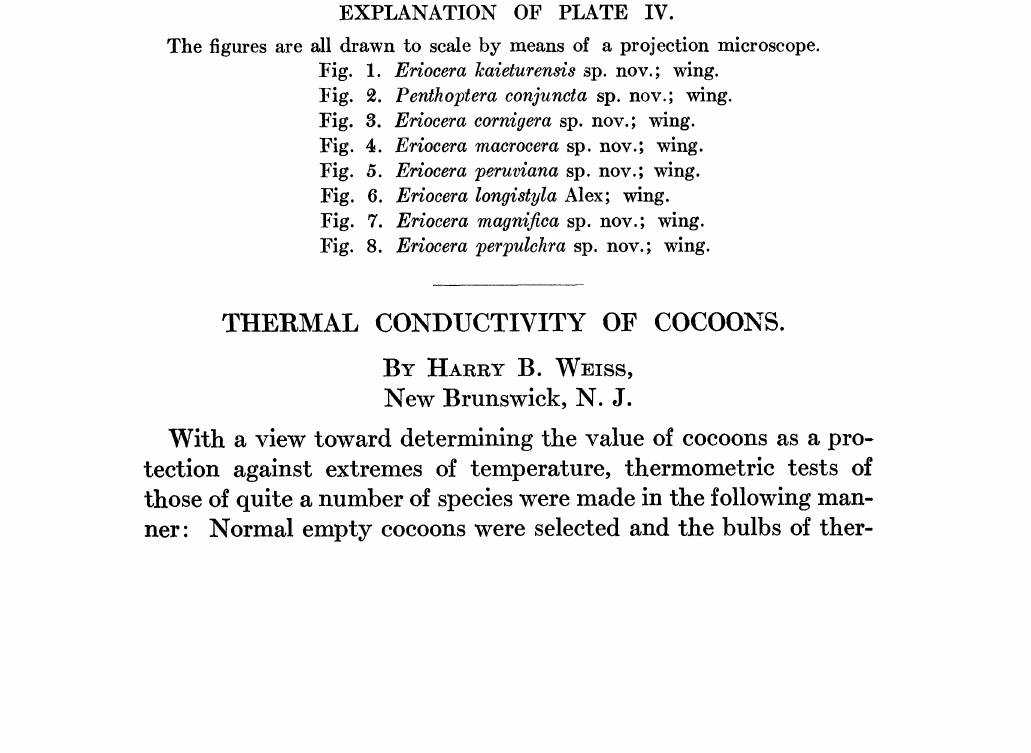
Fig. 2. Penthoptera conjuncta sp. nov.; wing. Fig. 8. Eriocera cornigera sp. nov.; wing. Fig. 4. Eriocera macrocera sp. nov.; wing. Fig. 5. Eriocera peruviana sp. nov.; wing. Fig. 6. Eriocera longistyla Alex; wing. Fig. 7. Eriocera magnifica sp. nov.; wing. Fig. 8. Eriocera perpulchra sp. nov.;